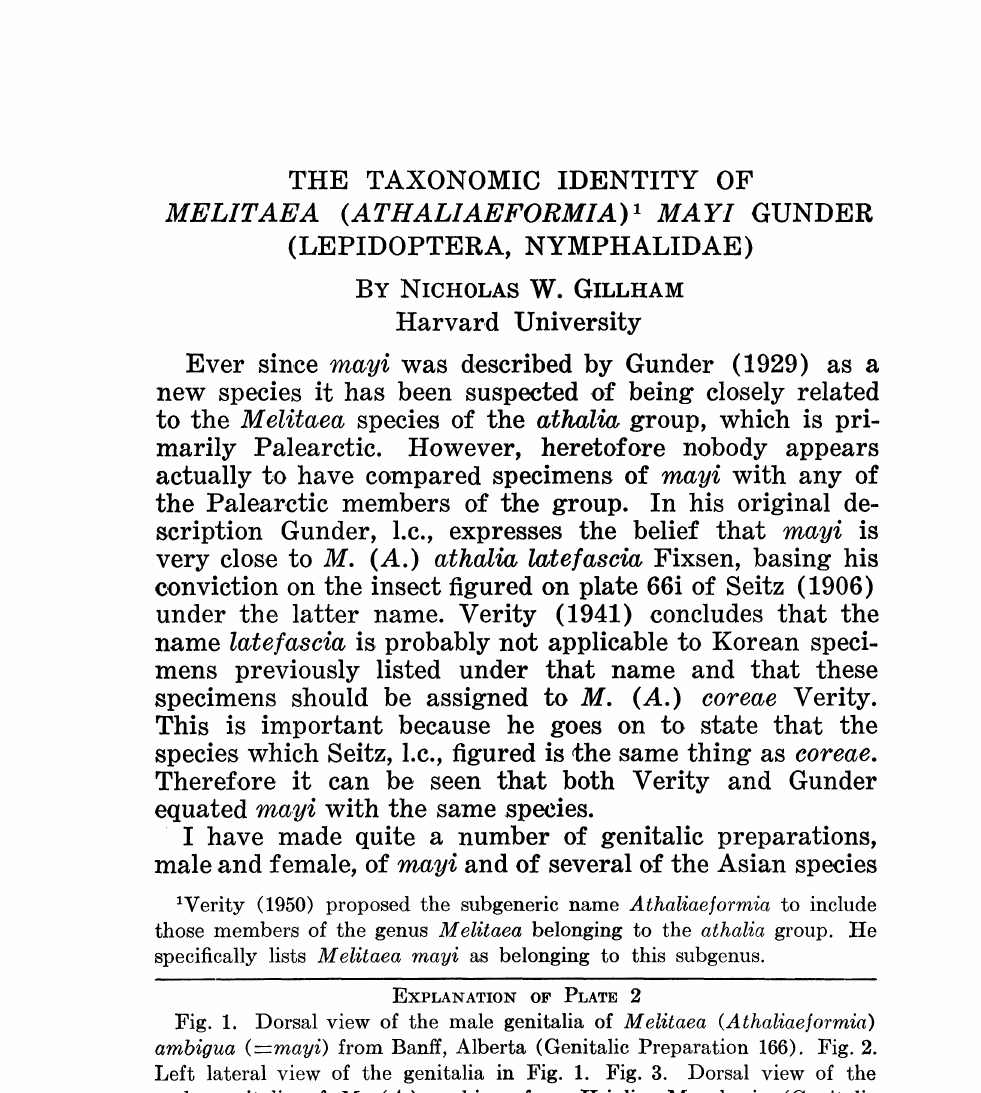
Fig. 1. Dorsal view of the male genitalia of Melitaea (Athaliae]ormia) ambigua (--mayi) from Banff, Alberta (Genitalic Preparation 166). Fig. 2. Left lateral view of the genitalia in Fig. 1. Fig. 3. Dorsal view of the male genitalia of M. (A.) ambigua from Hsiolin, Manchuria (Genitalic Preparation 217). Fig. 4. Left lateral view of the genitalia in Fig. 3. Fig. 5. Dorsal view of the male genitalia of another specimen from Itsiolin, Manchuria (Genitalic Preparation 218). Fig. 6. Left lateral view of the genitalia in Fig. 5. All figures drawn to the same scale. The aedeagus has been removed and is not shown in any of the